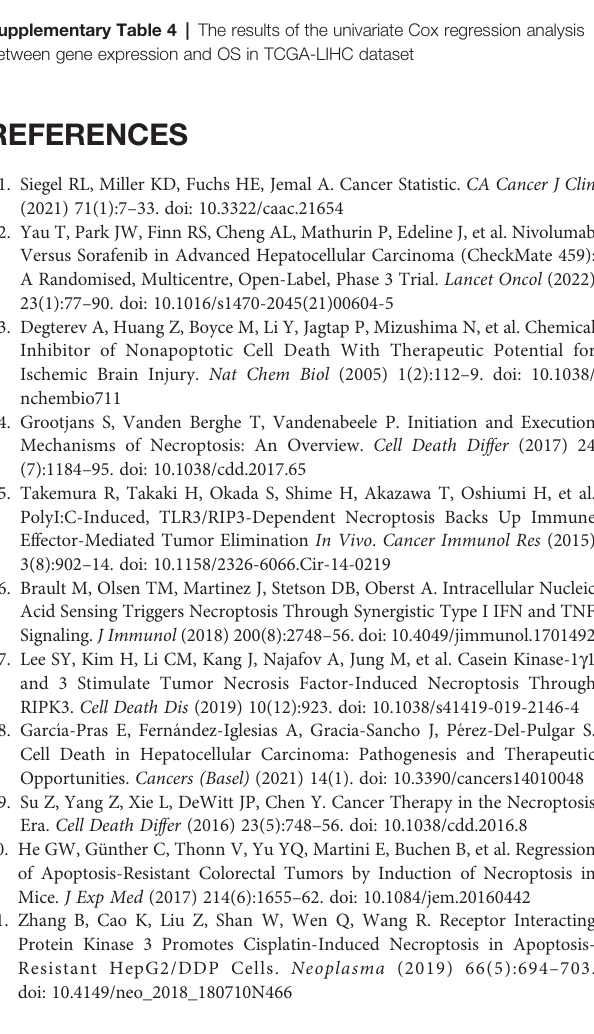
Supplementary Table 10 | Summary of detailed of NEC score for each HCC